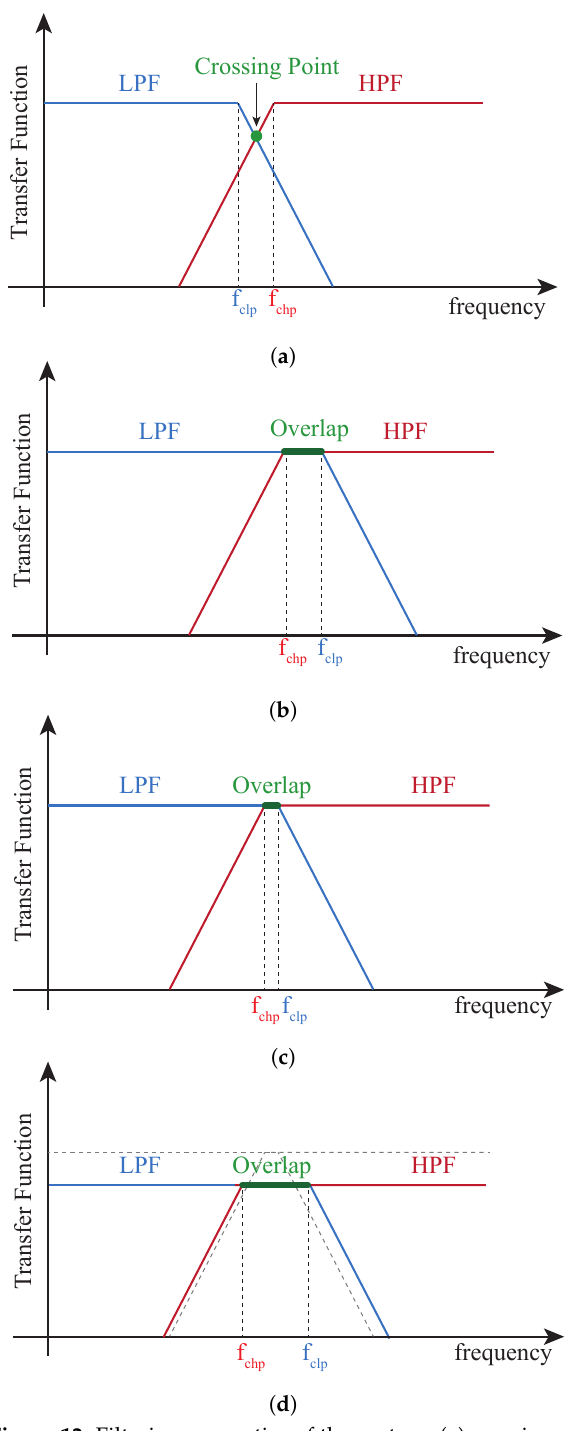
Figure 12. Filtering properties of the system: ( a ) crossing point of a LPF (blue line), and a HPF (red line), ( b ) increasing the temperature, ( c ) increasing the thickness, and ( d ) increasing the thickness further so that C a << C i + C p